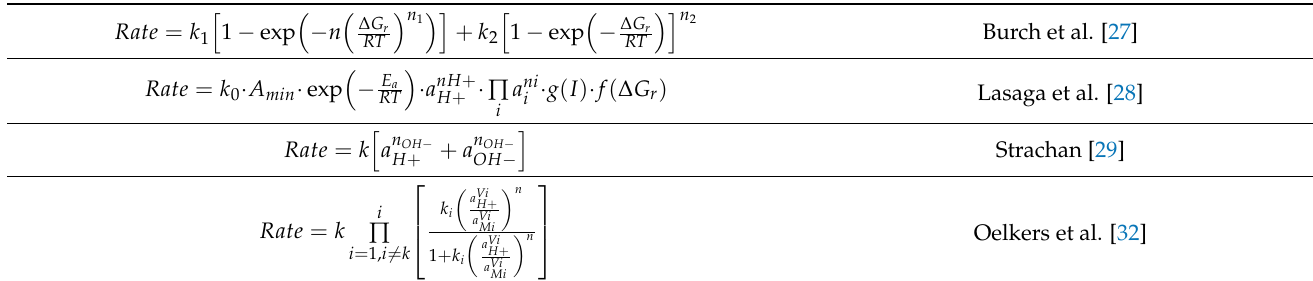
Table 1. Summary of current dissolution kinetics models for C 3 S and